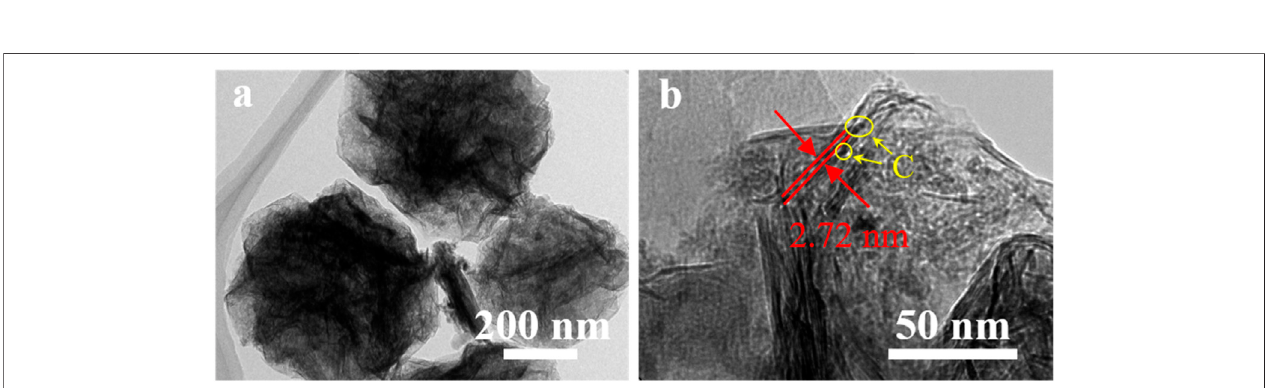
FIGURE 3 | HRTEM images of the printed hybrid Ti 3 C 2 T x /C nanospheres showing the enlarged interlayer distance. The yellow circles mark the embedded carbon nanoparticles.